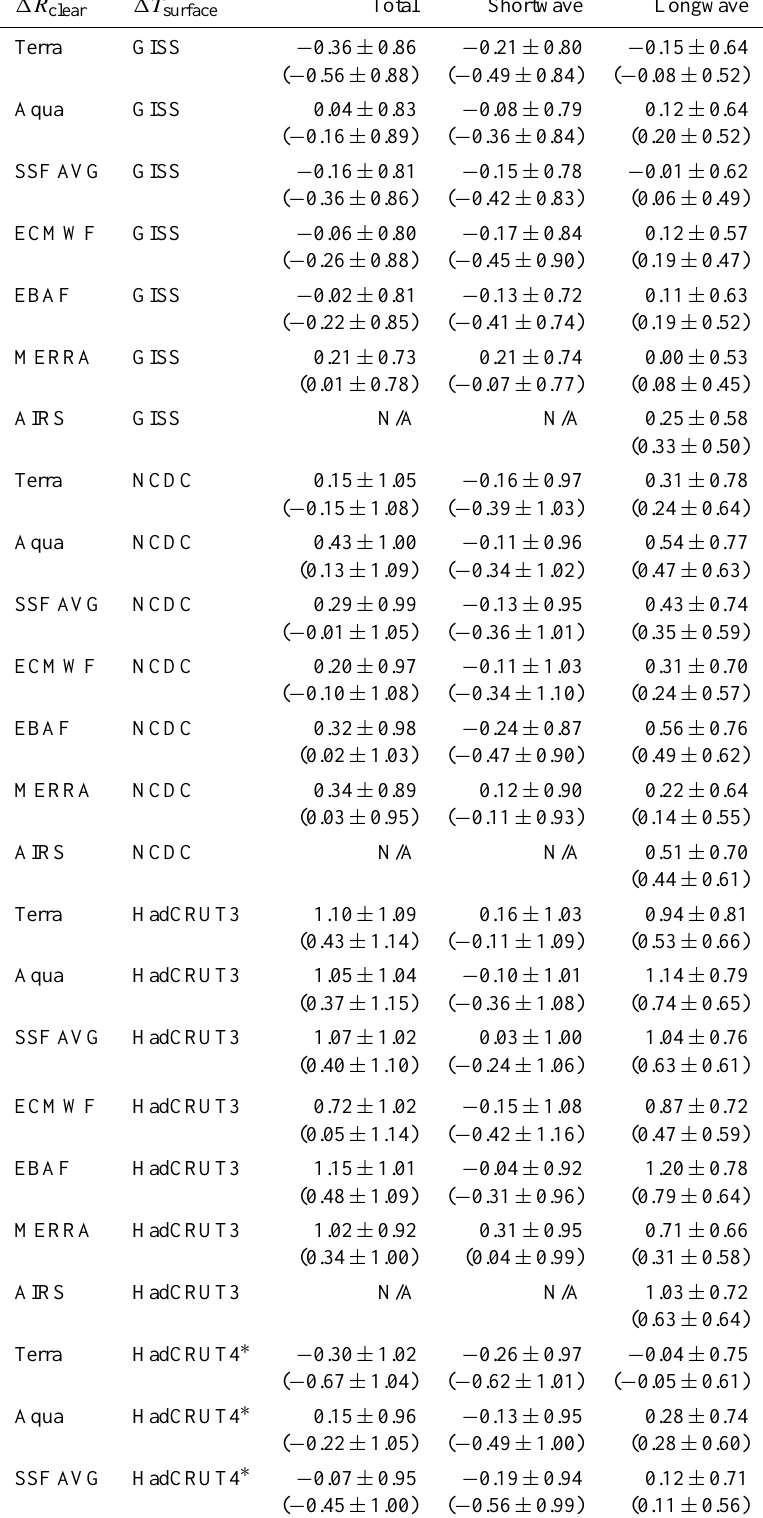
Table 4. Extended sensitivity tests. As in Table 2, but with additional temperature and clear-sky flux datasets, and only using monthly